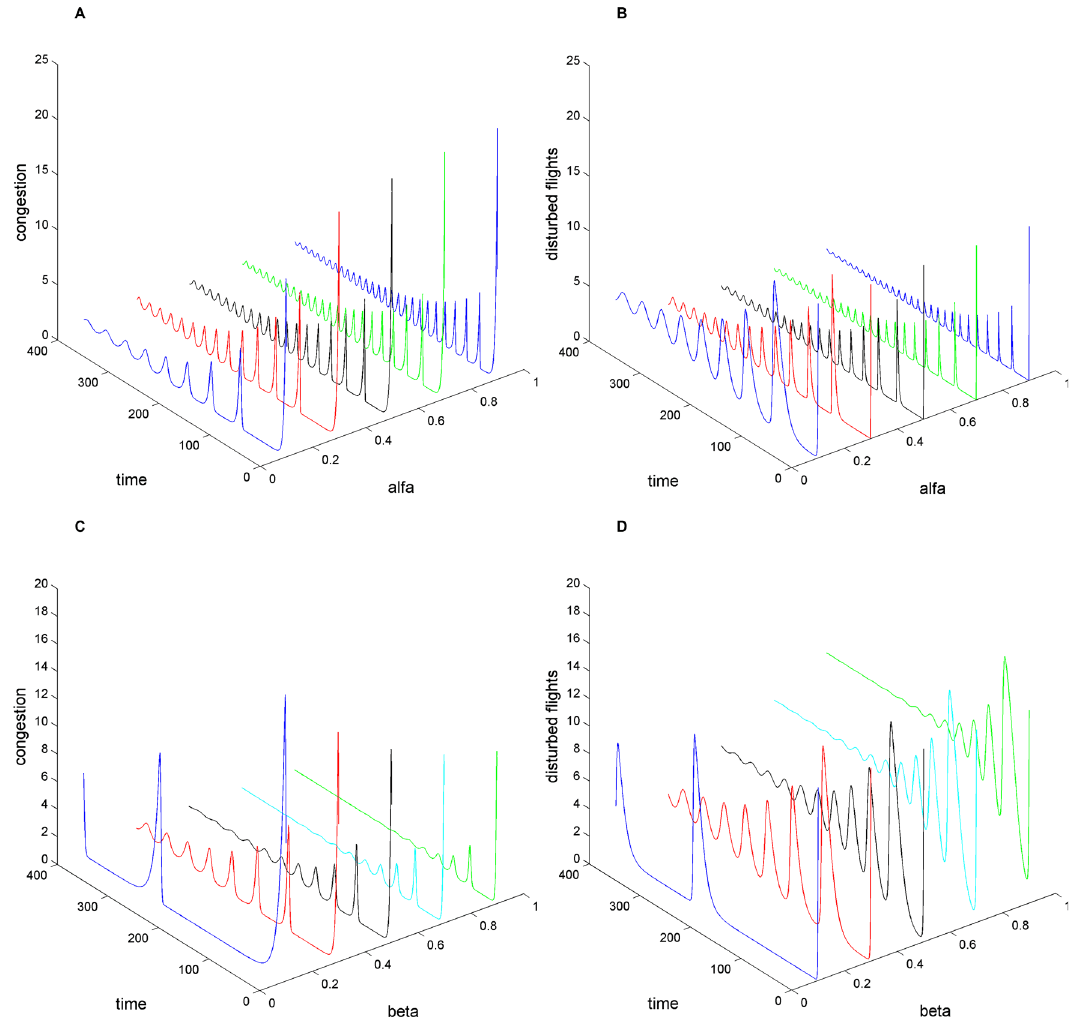
Fig 6. Effect of the main parameters in the evolution of congestion and disturbed flights. The largest congestion cluster per unit time: A) for the parameter alfa setting β = 1/3 and C) for the parameter beta setting α = 0.1. The disturbed flights per unit time: B) for the parameter alfa setting β = 1/3 and D) for the parameter beta setting α =